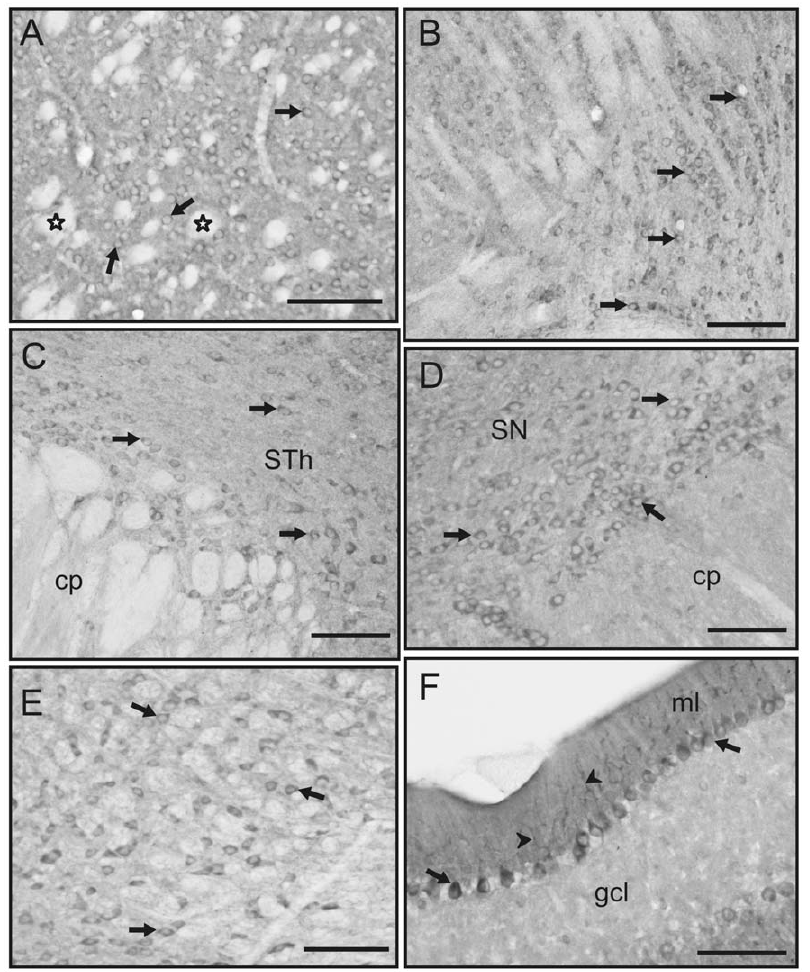
Figure 3. GSK3 b labeling in subcortical regions and in the cerebellum. A) GSK3 b -labeled neurons in the striatum (arrows). Note that fiber bundles crossing this area are devoid of immunolabeling (outlined stars). B–E) Labeled neurons (arrows) in the geniculate nucleus of the thalamus ( B ) appear in ‘‘rows’’ strongly immunostained with clear nucleus and almost no processes visible. In the subthalamic nucleus (STh), labeled neurons are surrounded by labeling that may correspond with small processes ( C ). The same type of labeling is observed in the substantia nigra (SN) where neurons present strongly stained cell bodies ( D ). The red nucleus ( E ) shows GSK3 b positive neurons (arrows) interspersed with negative fiber bundles. F) In the cerebellum, Purkinje cells are GSK3 b immunolabeled (arrows). There is strong labeling in the molecular layer (ml), while the granule cell layer (gcl) is almost devoid of staining. Note also that Purkinje cell dendrites in the molecular layer are strongly labeled (arrowheads). [cp: cerebellar peduncle; Scale bars: 50 m m in all